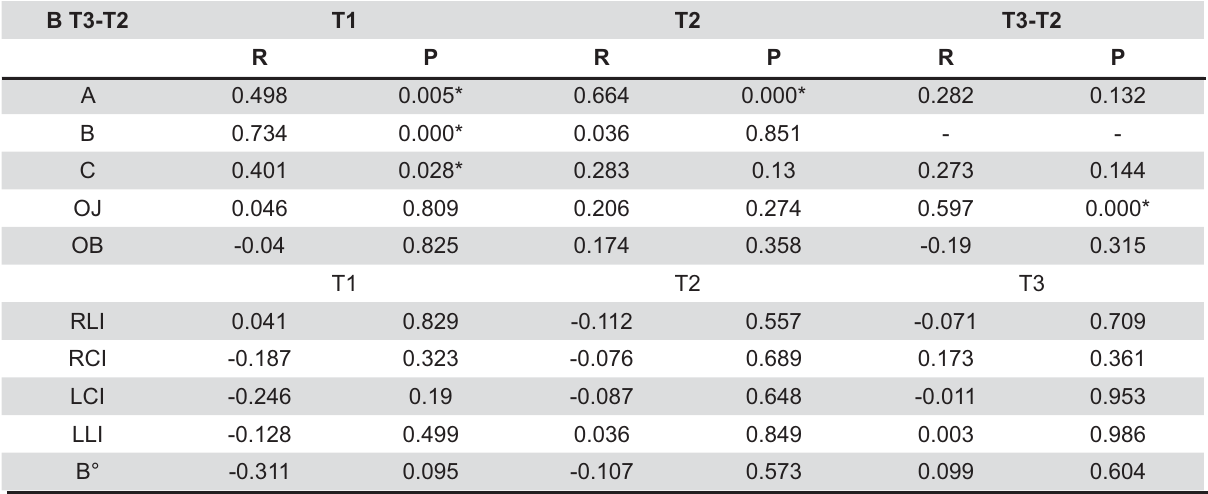
difference (Tukey test). SD=Standard Deviation Table 2- Correlation of several variables with midline diastema relapse (B B T3-T2